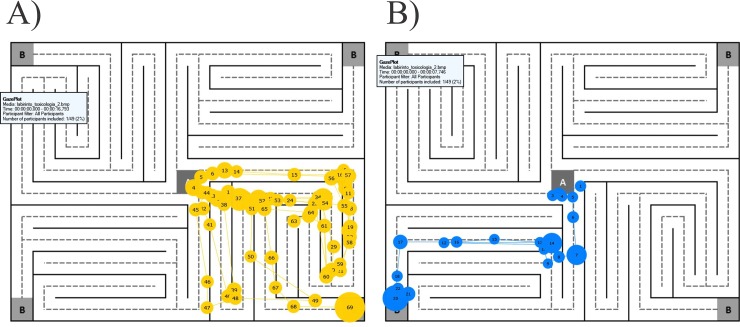
Gaze plots representing the fixations and saccades.Performance of Subject A01014 (male, 22 years old) in both experimental conditions. A) Eye movements obtained from the alcohol condition. B) Eye movements obtained from the placebo condition. Circles depict fixations and their diameters indicate duration of each fixation. Numbers within the circles represent the fixation sequence. Lines connecting fixations represent the saccades sequence.